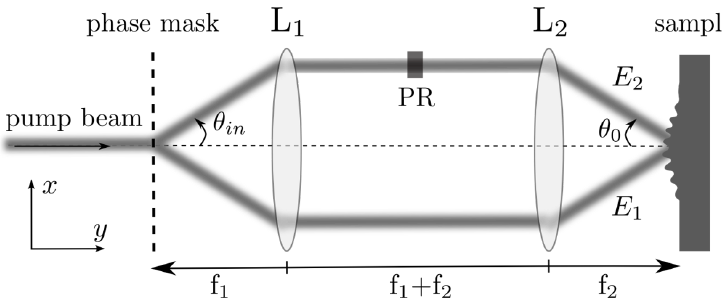
Figure 4. Schematics of a wavenumber excitation setup using a diffraction phase mask to split a